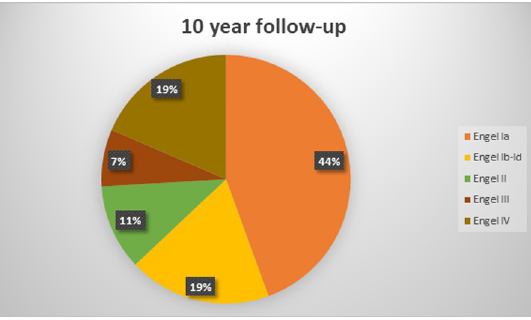
Fig 5. Long-term seizure outcomes. 10 year follow-up, 27 patients (Engel classification).